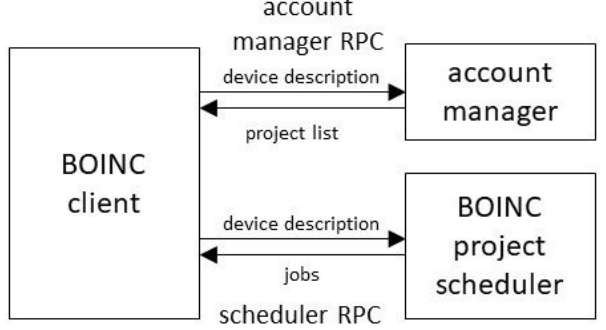
Figure 1. BOINC’s account manager architecture.